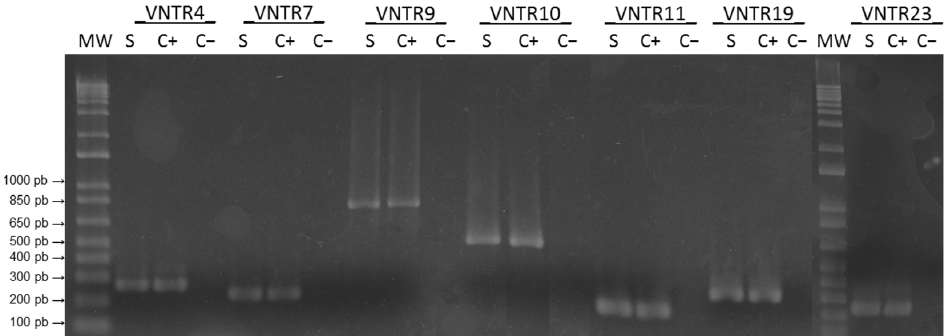
Figure 2. PCR analysis of the polymorphism of seven representative VNTR loci. MW: Molecular weight marker (1 Kb plus DNA ladder). (S) Sample from genomic DNA from Leptospira isolate (named NEG7); (C+) positive control (genomic DNA of L. interrogans serovar Copenhageni strain Fiocruz L1-130) and (C-) negative control (water template).